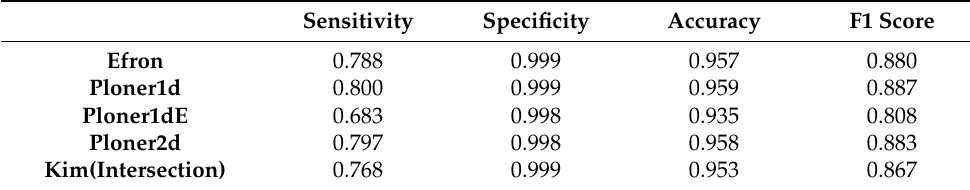
Table 4. Mean shift scenario (two-sided alternative): Performance measures when µ = 1.5 and cutoff = 0.1.